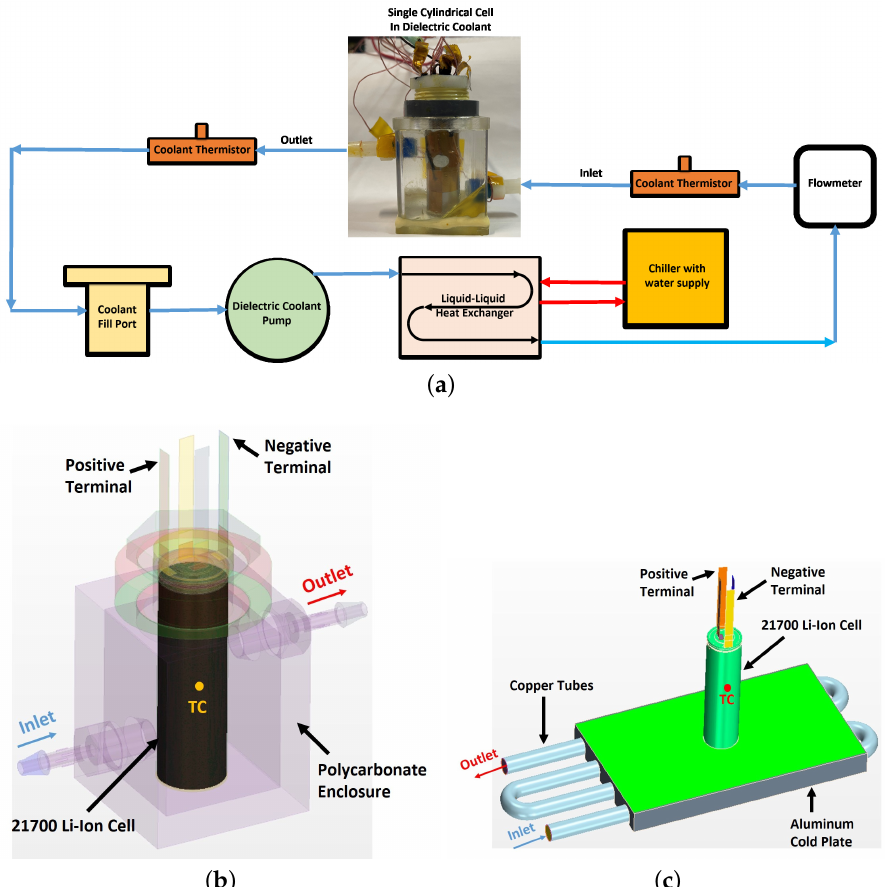
Figure 4. Schematic of the ( a ) overall experimental setup and the geometry employed in [7] for the numerical simulations of ( b ) submerged-cell (immersion) cooling, and ( c ) cold-plate